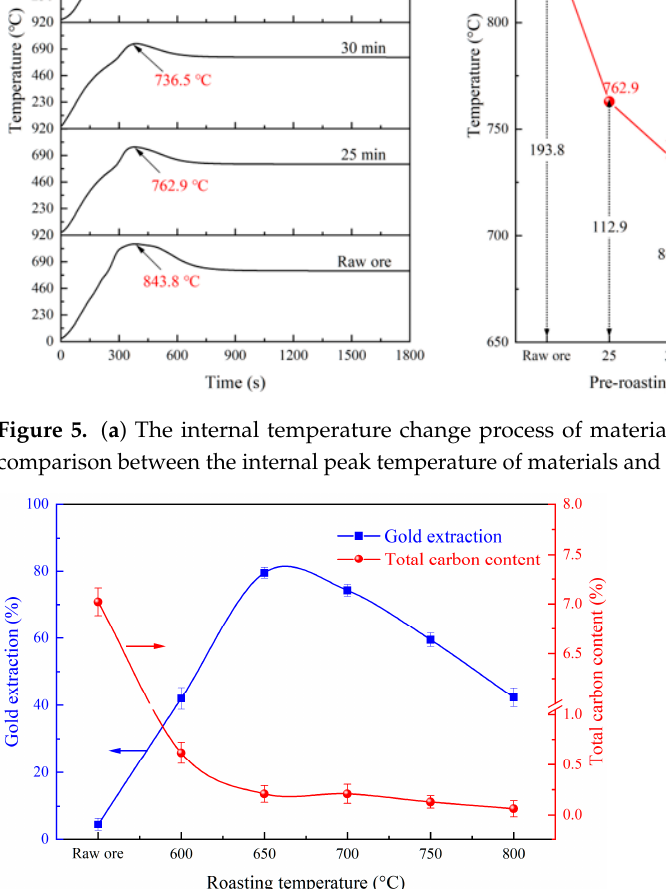
Figure 5. ( a ) The internal temperature change process of materials during roasting, and ( b ) the com- parison between the internal peak temperature of materials and the preset roasting temperature.